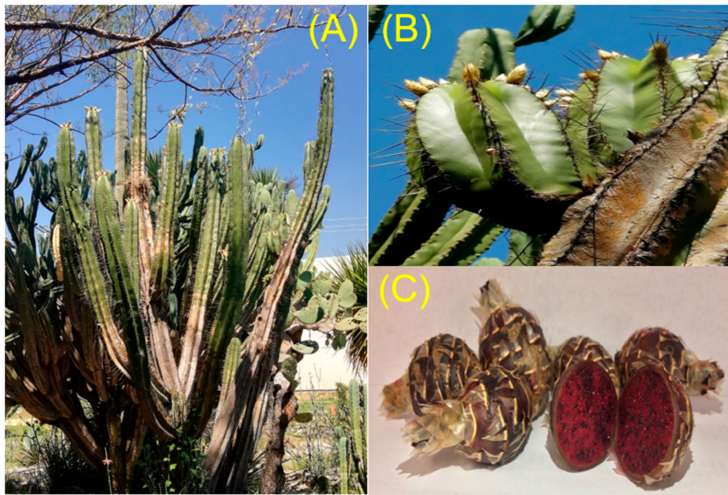
Figure 2. ( A ) Escontria chiotilla plant, ( B ) E. chiotilla flower, and ( C ) E. chiotilla